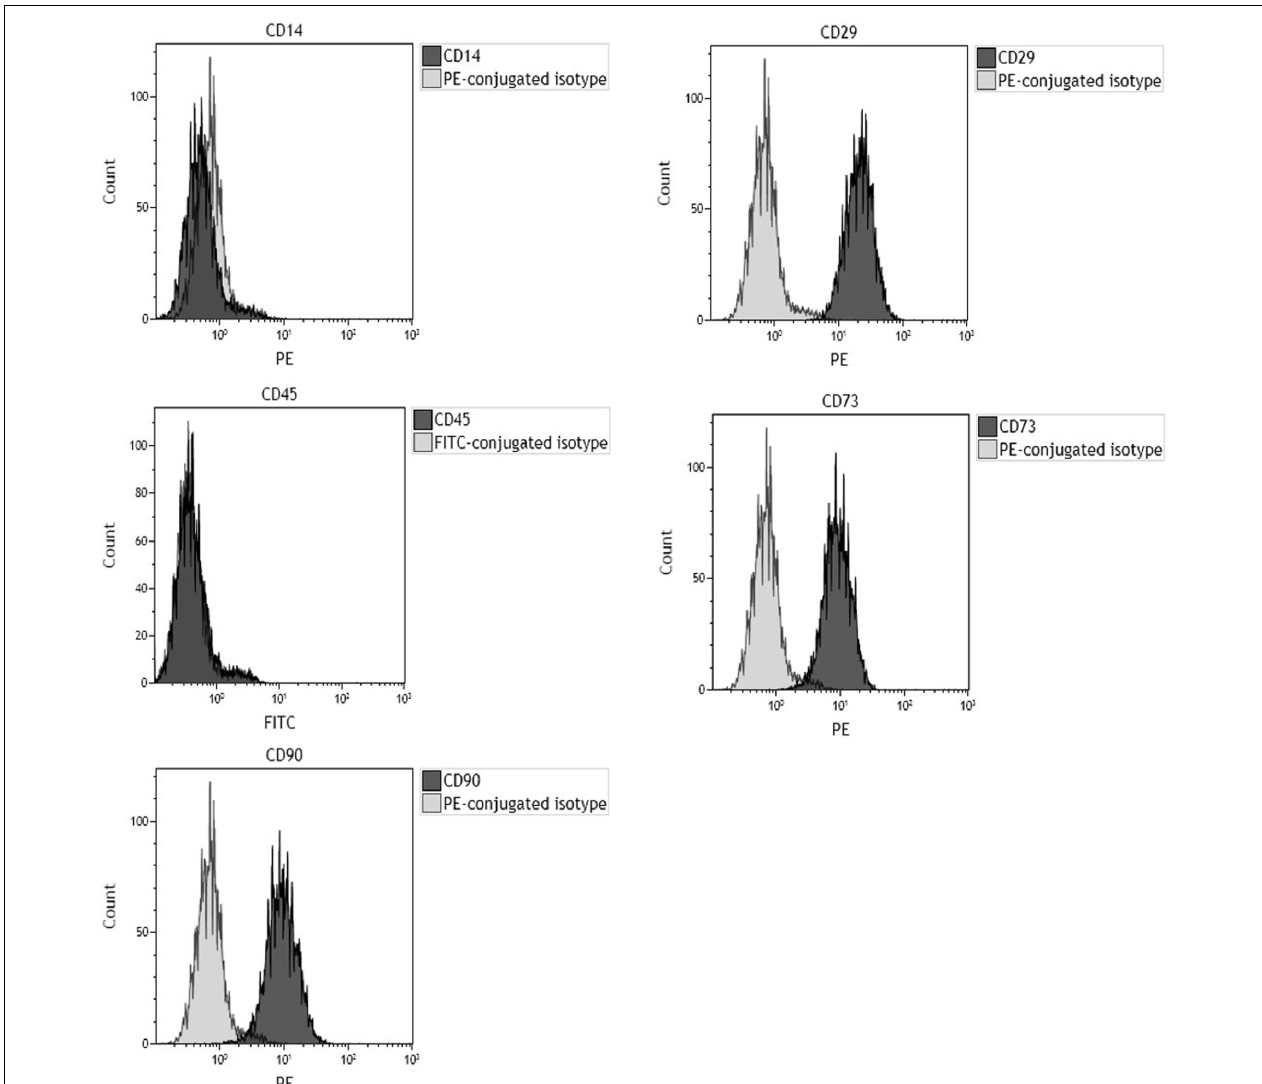
FIGURE 1 | Flow cytometric characterization of cell-surface antigen profile of human bone marrow-derived mesenchymal stem cells (hBMSCs) obtained from bone marrow of orthopedic patients. Plots are representative of three distinct analyses, employing hBMSCs derived from a single patient. In each graph, the dark gray histogram plot represents sample stained with the indicated antibody, whereas the light gray histogram plot represents isotype control. CD29, CD73, and CD90 represent hMSC-positive surface markers, while CD14 and CD45 are hMSC-negative surface markers. Phenotypic analysis confirmed that cells tested positive for hMSC markers (CD29, CD73, and CD90) and negative for hematopoietic (CD45) and macrophage (CD14) markers.